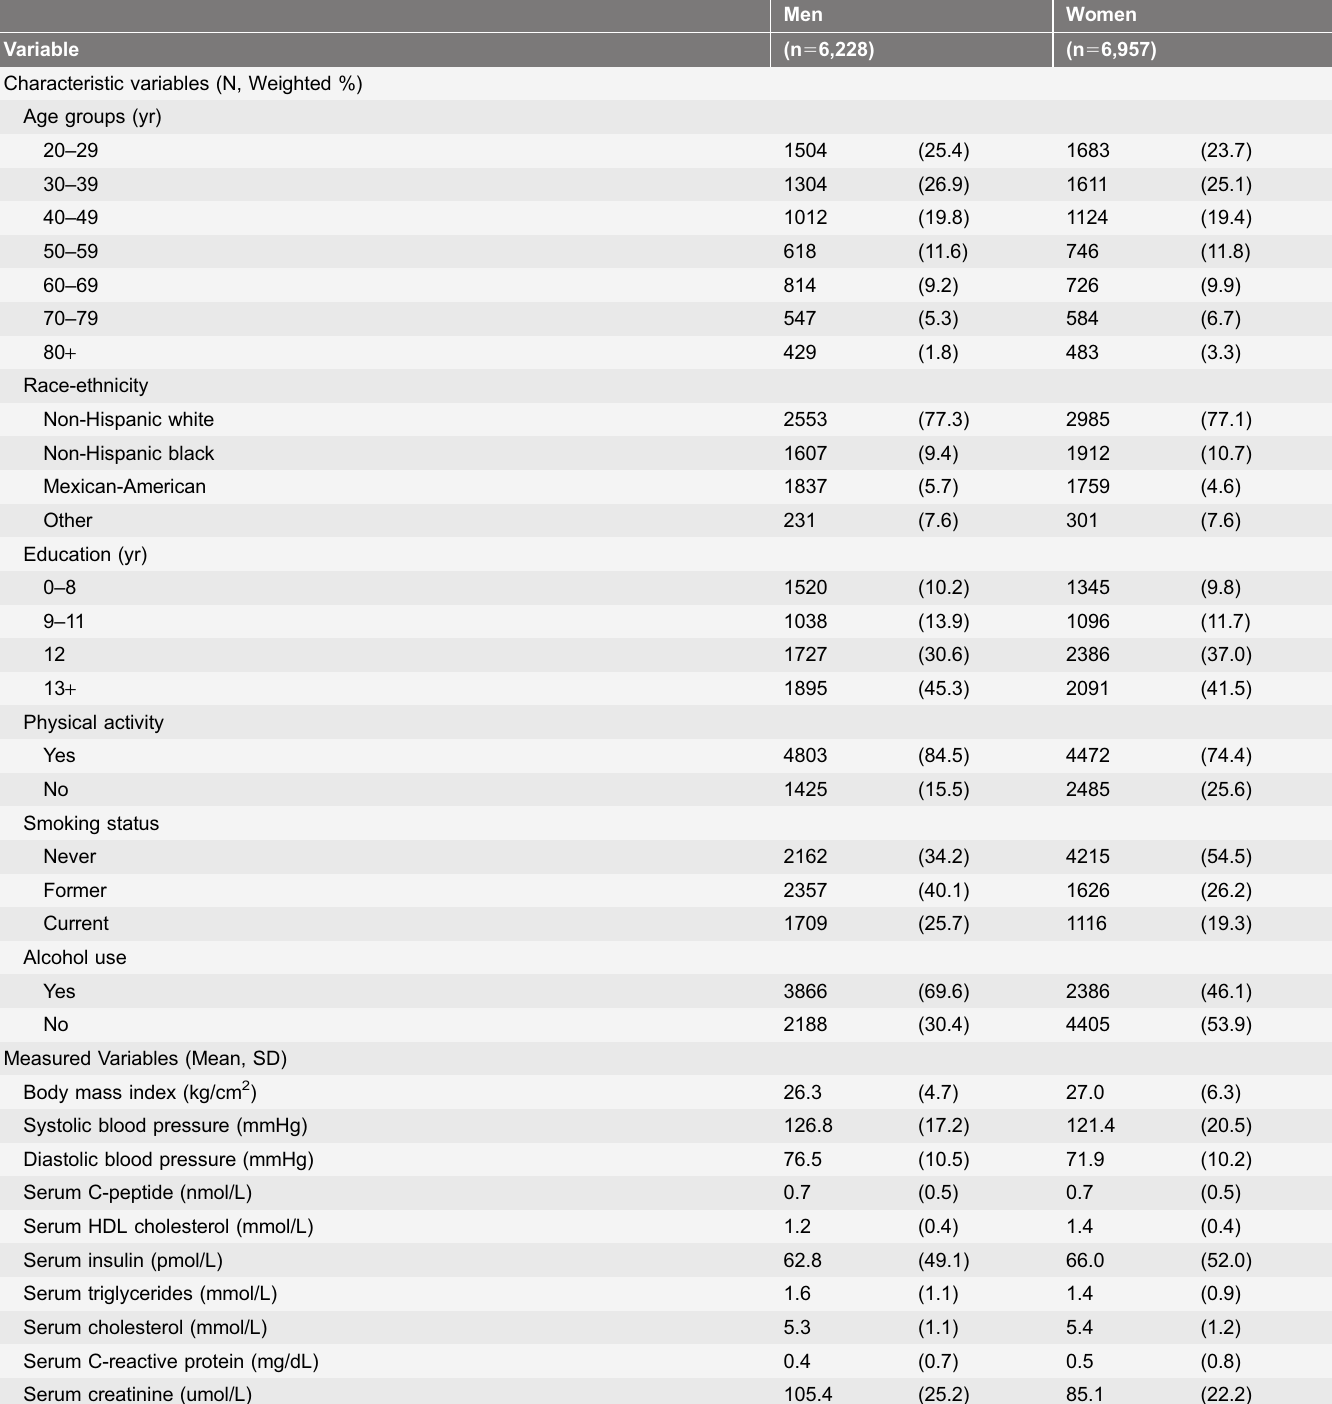
Table 1. Baseline characteristics of study participants by sex from National Health and Nutrition Examination Survey